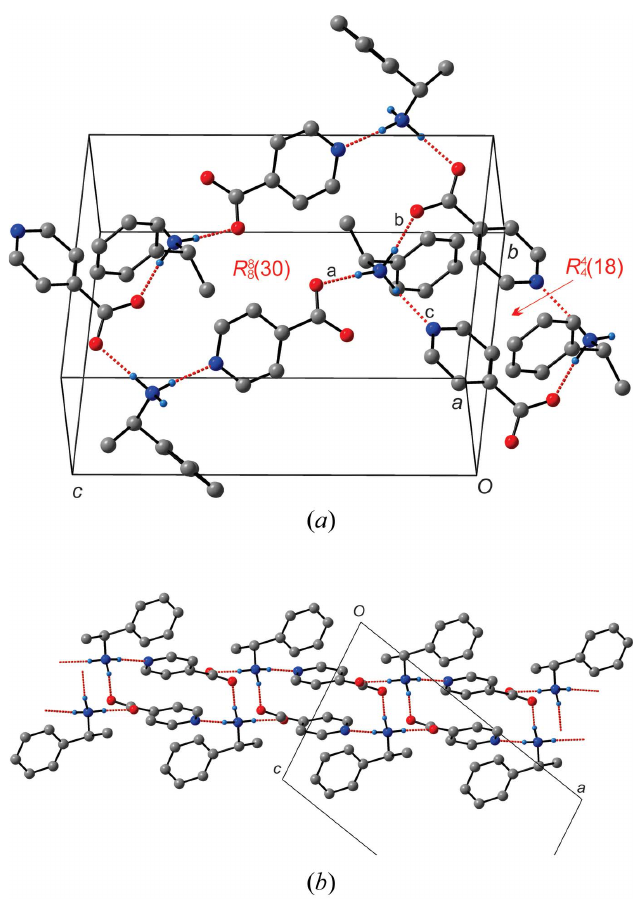
Figure 2 ( a ) Detailed view of the three hydrogen bonds forming two types of hydrogen-bonded rings in (I). ( b ) Side-on view of the two-dimensional, hydrogen-bonded layers formed. 582 Blignaut and Lemmerer (cid:4) C 8 H 12 N + (cid:2) C 6 H 4 NO 2 (cid:3) and 6 related salts